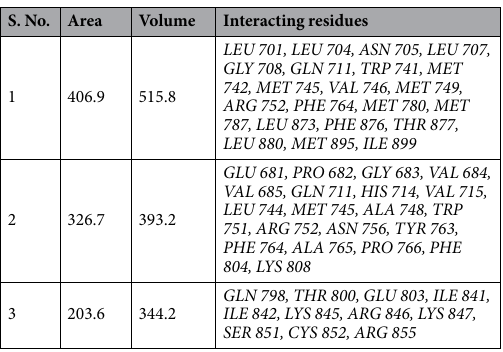
Table 1. Identified active sites of receptor 1E3G with the corresponding interacting residues.